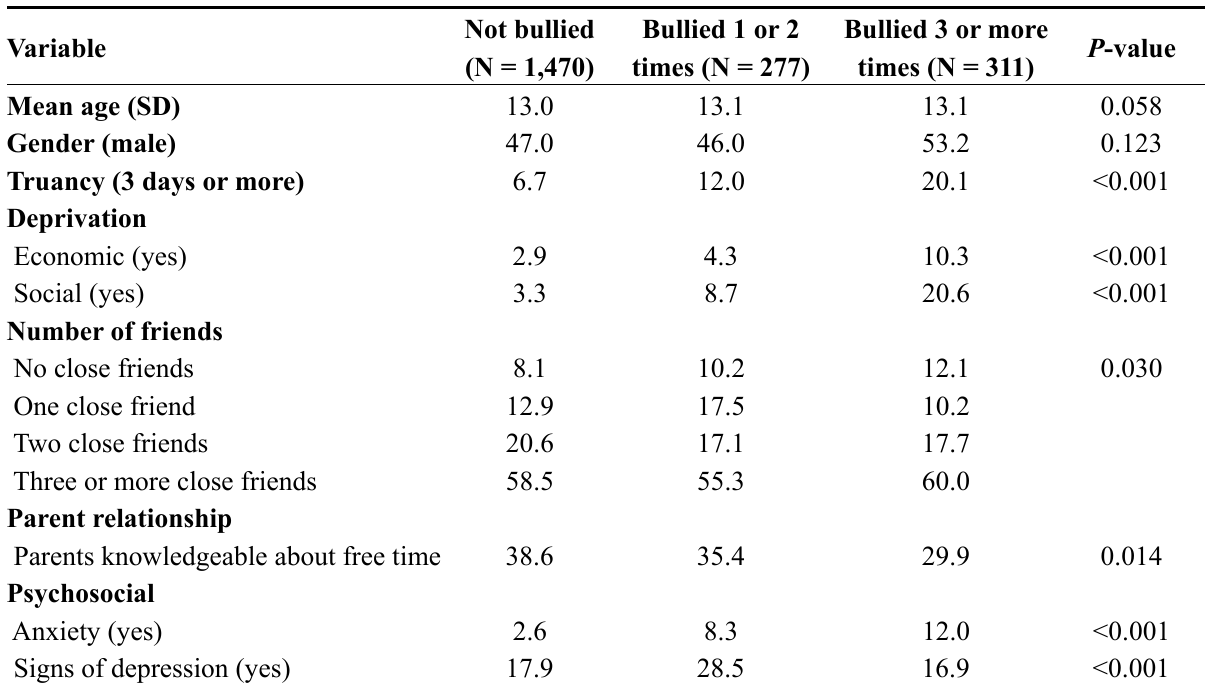
Table 4. Bivariate analyses according to days of exposure to bullying among adolescents in Dar es Salaam,